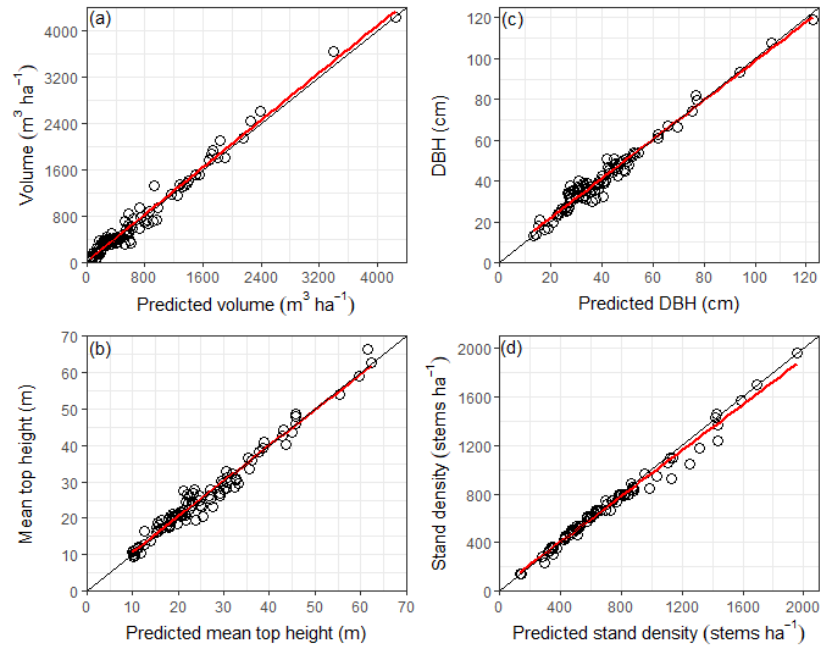
Figure 8. Plots of predicted against measured values for ( a ) volume, ( b ) mean top height, ( c ) diameter at breast height and ( d ) stand density. Plots with two or more repeated measurements were included, and the last prediction for each plot is shown. The 1:1 line is denoted by the solid black line, while the solid red line shows a linear relationship of best fit through the data.